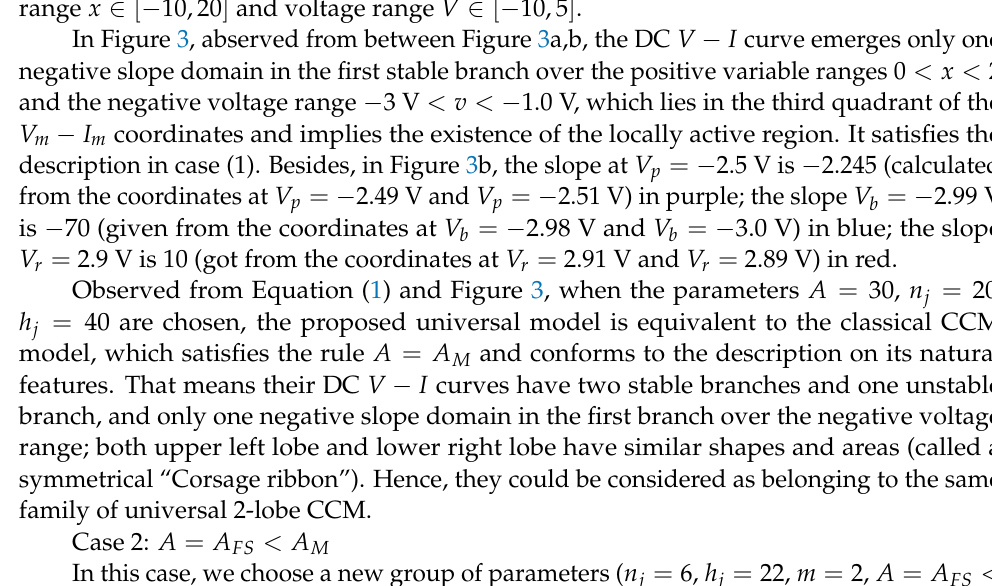
Figure 9. Phase trajectory in Ivs . V : ( a ) m = 4; ( b ) m = 6; ( c ) m = 8; ( d ) m = 10; ( e ) m = 12; ( f ) m = 14. The corresponding DC V − I curves are drawn in Figure 3 over the input variable range x ∈ [ − 10, 20 ] and voltage range V ∈ [ − 10, 5 ]